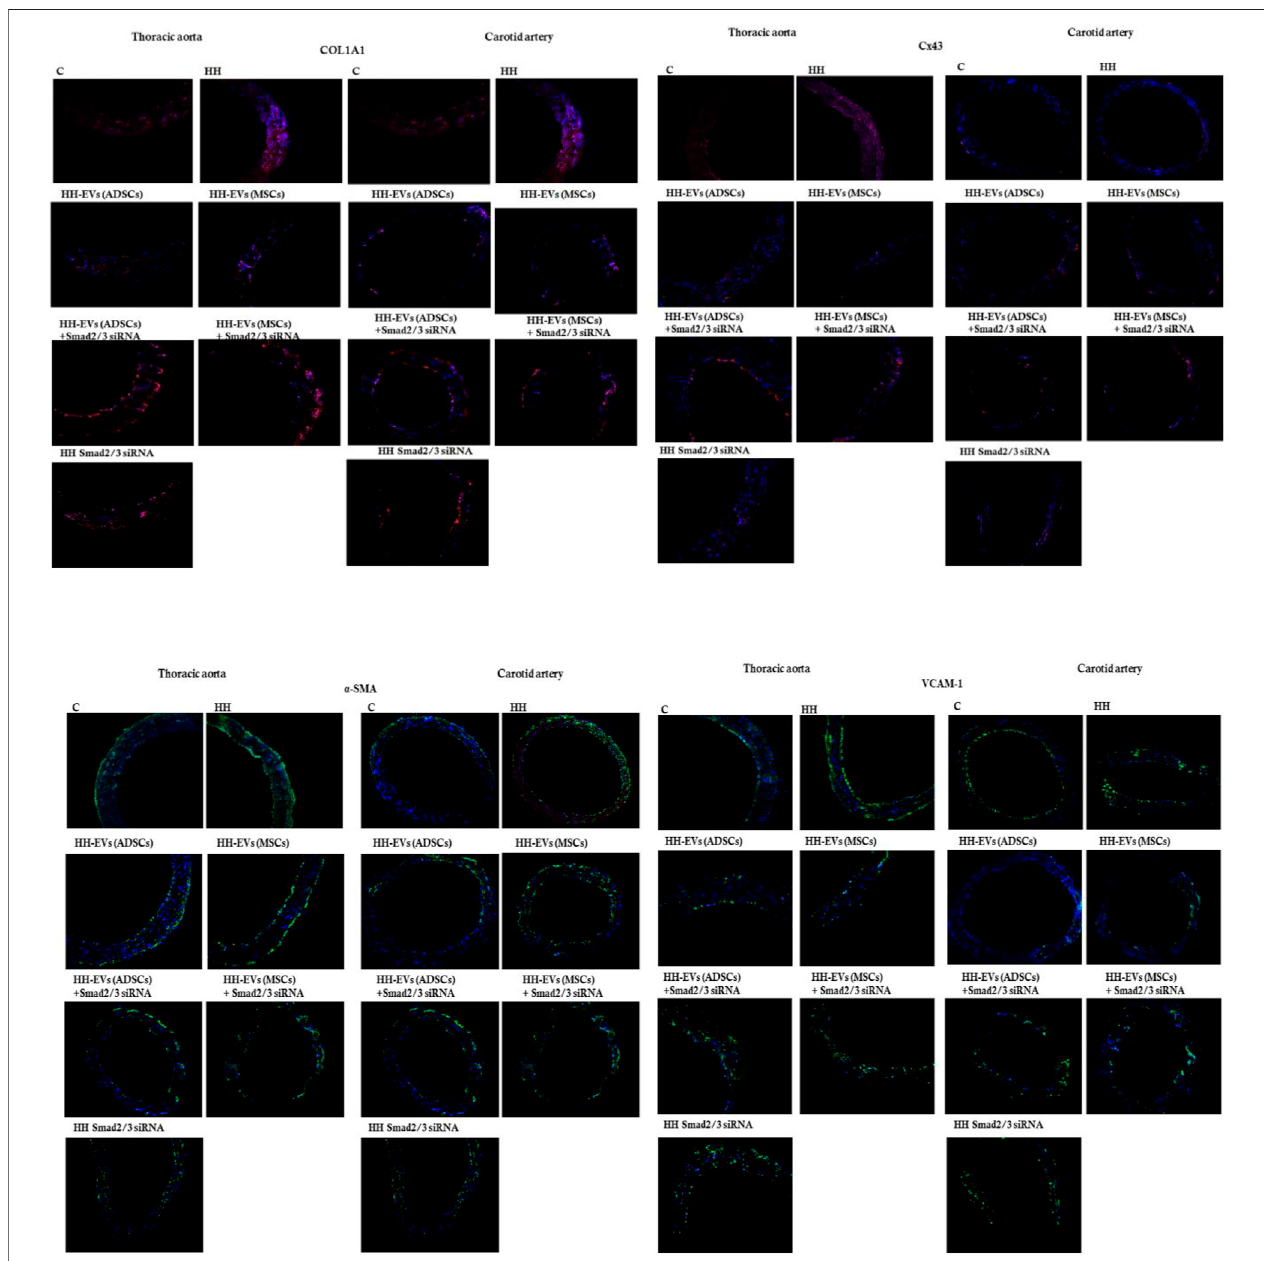
FIGURE 9 | Representative immuno fl uorescence images for the evaluation of in fl ammatory markers speci fi c to vascular dysfunction after 4 months of the hyperlipemic – hypertensive diet and the stem cell-derived EV-based treatment or siRNA-based treatment. The thin cryosections from the thoracic aorta (on the left) and carotid artery (on the right) harvested from all experimental groups (C, HH, HH-EVs (ADSCs), HH-EVs (MSCs), HH-EVs(ADSCs)+Smad2/3siRNA, HH- EVs(MSCs)+Smad2/3siRNA, and HH-Smad2/3siRNA) were immuno-labeled for the following: 1) structural proteins: collagen type I (COL1A1) alpha smooth muscle actin ( α -SMA), and connexin 43 (Cx43); 2) proteins involved in cell adhesion and vascular remodeling: matrix metalloproteinase-2 (MMP-2) and vascular cell adhesionmolecule-1(VCAM-1); 3) immunecellin fi ltrate:Tcells(CD3e+),totalmacrophages(CD68 + ),andM1macrophages(MHC-II+);and 4) cytosolicROSproduction (dihydroethidium (DHE) was oxidized by cytosolic ROS to fl uorescent ethidium bromide that intercalates DNA yielding a bright red nuclear fl uorescence). Nuclei were shown in blue fl uorescence by DAPI dye staining. Each experiment point was performed in triplicate, from two different sets of experiments. A total of fi ve different microscopic fi elds for each experimental point were analyzed. Total magni fi cation: ×20. The images were quanti fi ed using the ImageJ program.